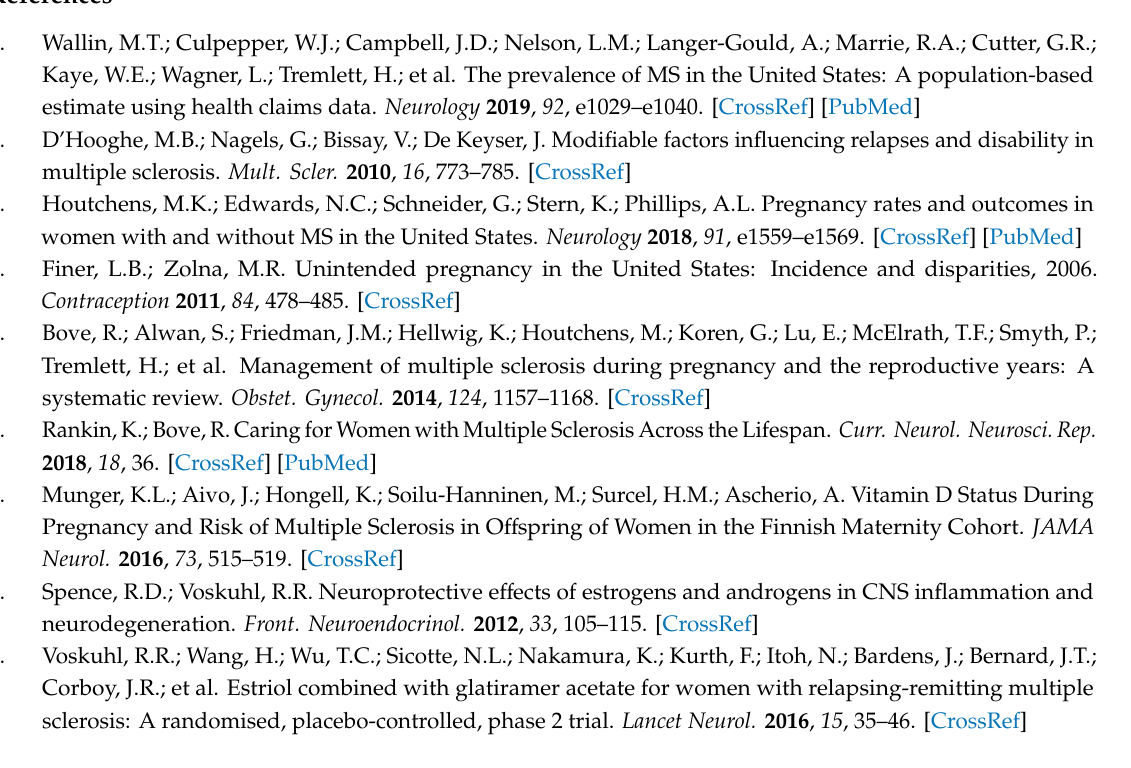
Table S1: Updated information on the safety of DMT use during pregnancy. Funding: This research received no external